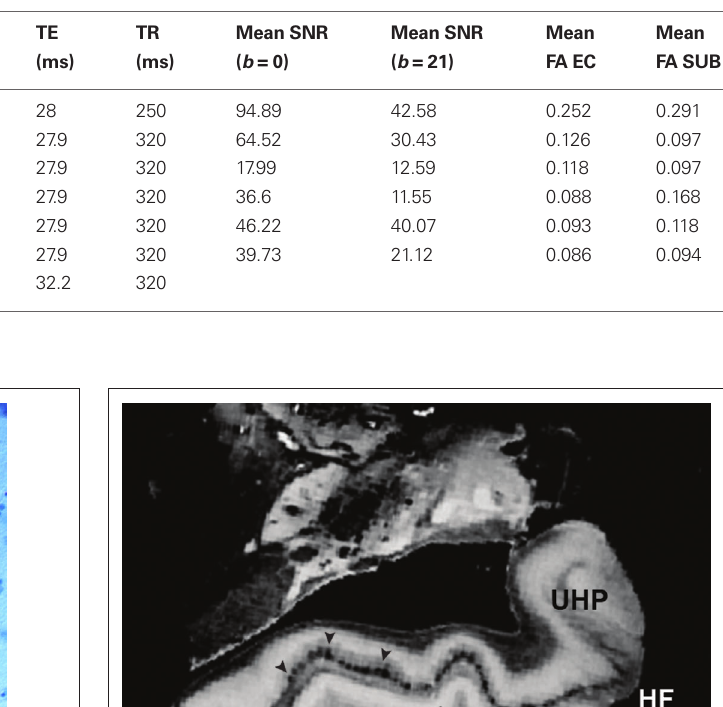
Table 1 | Demographic information, Mri parameters and fractional anisotropy for all cases.